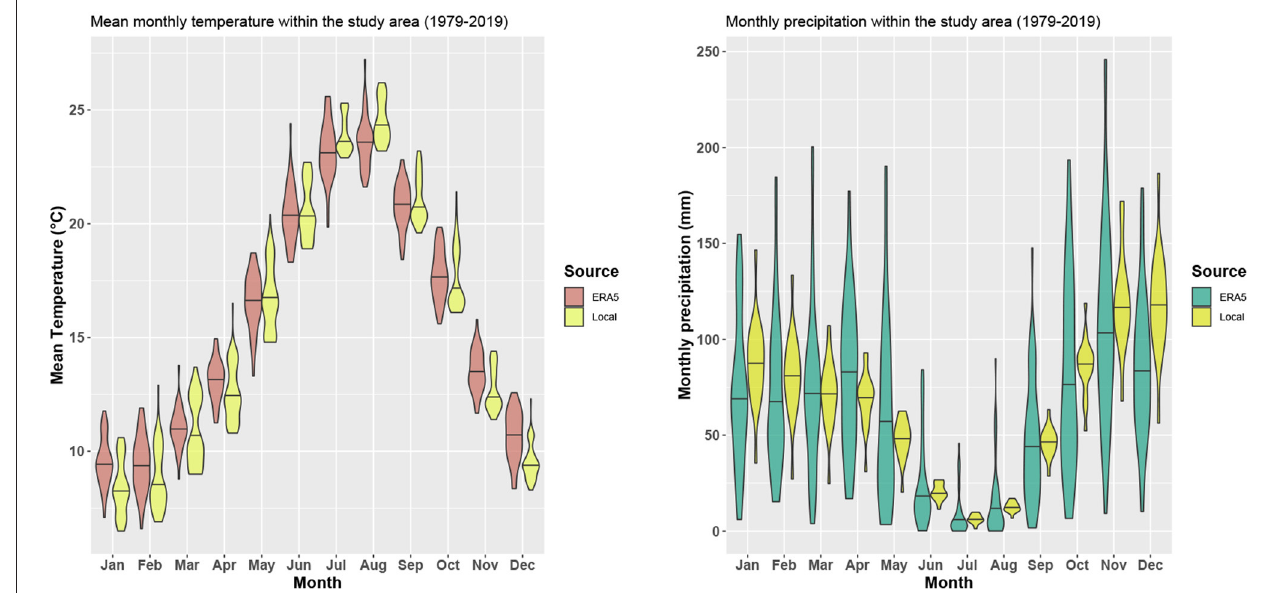
FIGURE 5 | Comparison of ERA5 2 m air temperature and rainfall to local weather station data from the study